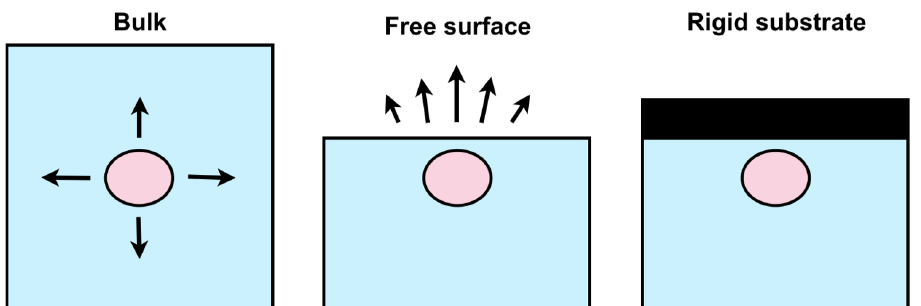
Figure 2. Precipitation in the bulk and near free or confined surfaces. The left panel illustrates the case of precipitate formation in the bulk, sufficiently far away from interfaces and surfaces. A lattice mismatch between the precipitate and matrix leads to elastic distortions in both of them, as illustrated here for a precipitate with a larger volume (positive eigenstrain). In the central panel, the precipitate is close to a free surface, where the material can relax in the outward normal direction, such that elastic stresses are reduced. Consequently, the elastic energy is here lower than in the bulk case. In the right panel, the precipitate is close to an interface to an elastically stiffer phase or a rigid substrate. If it is coherently connected to the matrix phase, elastic relaxation is hampered or suppressed near the matrix-substrate interface. In this case, the elastic energy of the system is even higher than in the bulk case, and precipitation therefore